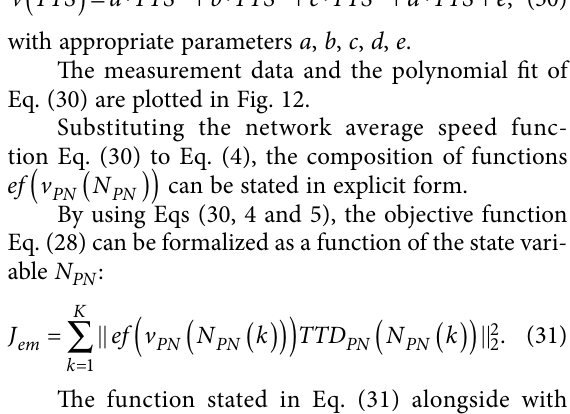
with appropriate parameters a , b , c , d , e . The measurement data and the polynomial fit of Eq. (30) are plotted in Fig. 12. Substituting the network average speed func- tion Eq. (30) to Eq. (4), the composition of functions can be stated in explicit form.